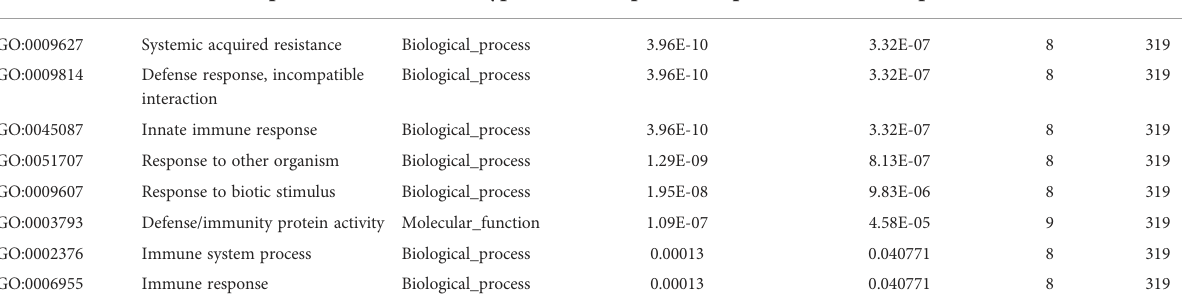
TABLE 2 Representative GO-enrichment of the down-regulated DEGs ( NtCOI1 -RI vs. control).